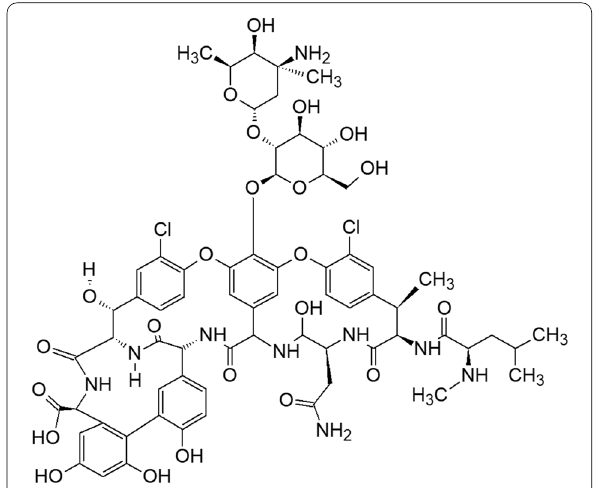
Fig. 4 Structural formula of vancomycin